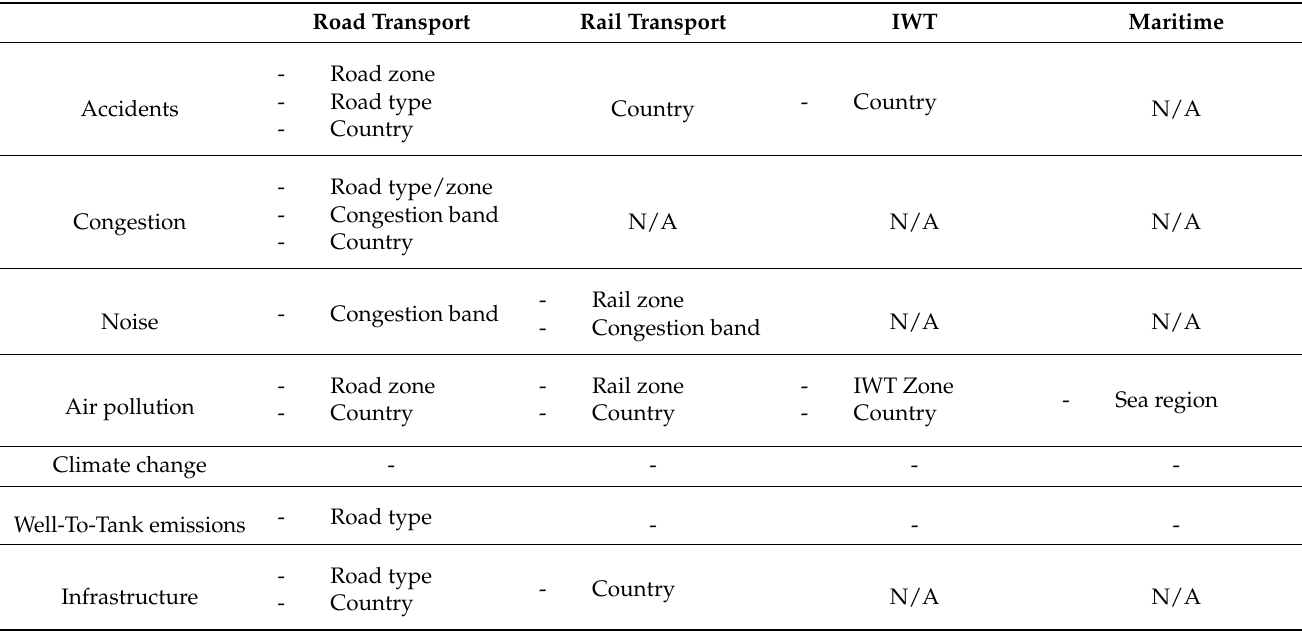
Table 2. Link characteristics used for choosing the external cost factors or damage costs. Road